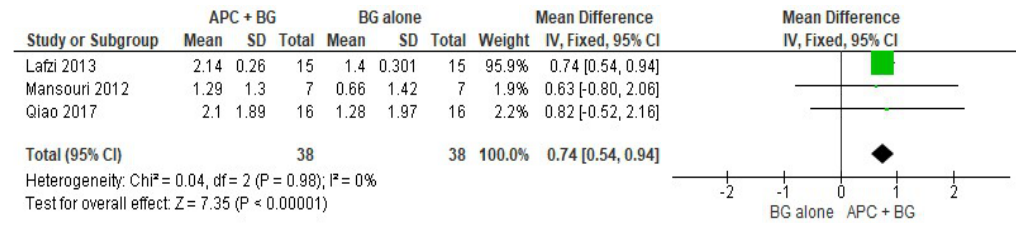
Figure 8. Forest plot showing the effect on horizontal clinical attachment level for comparison of APC + BG versus BG alone at end of all-follow-up (6–12 m).